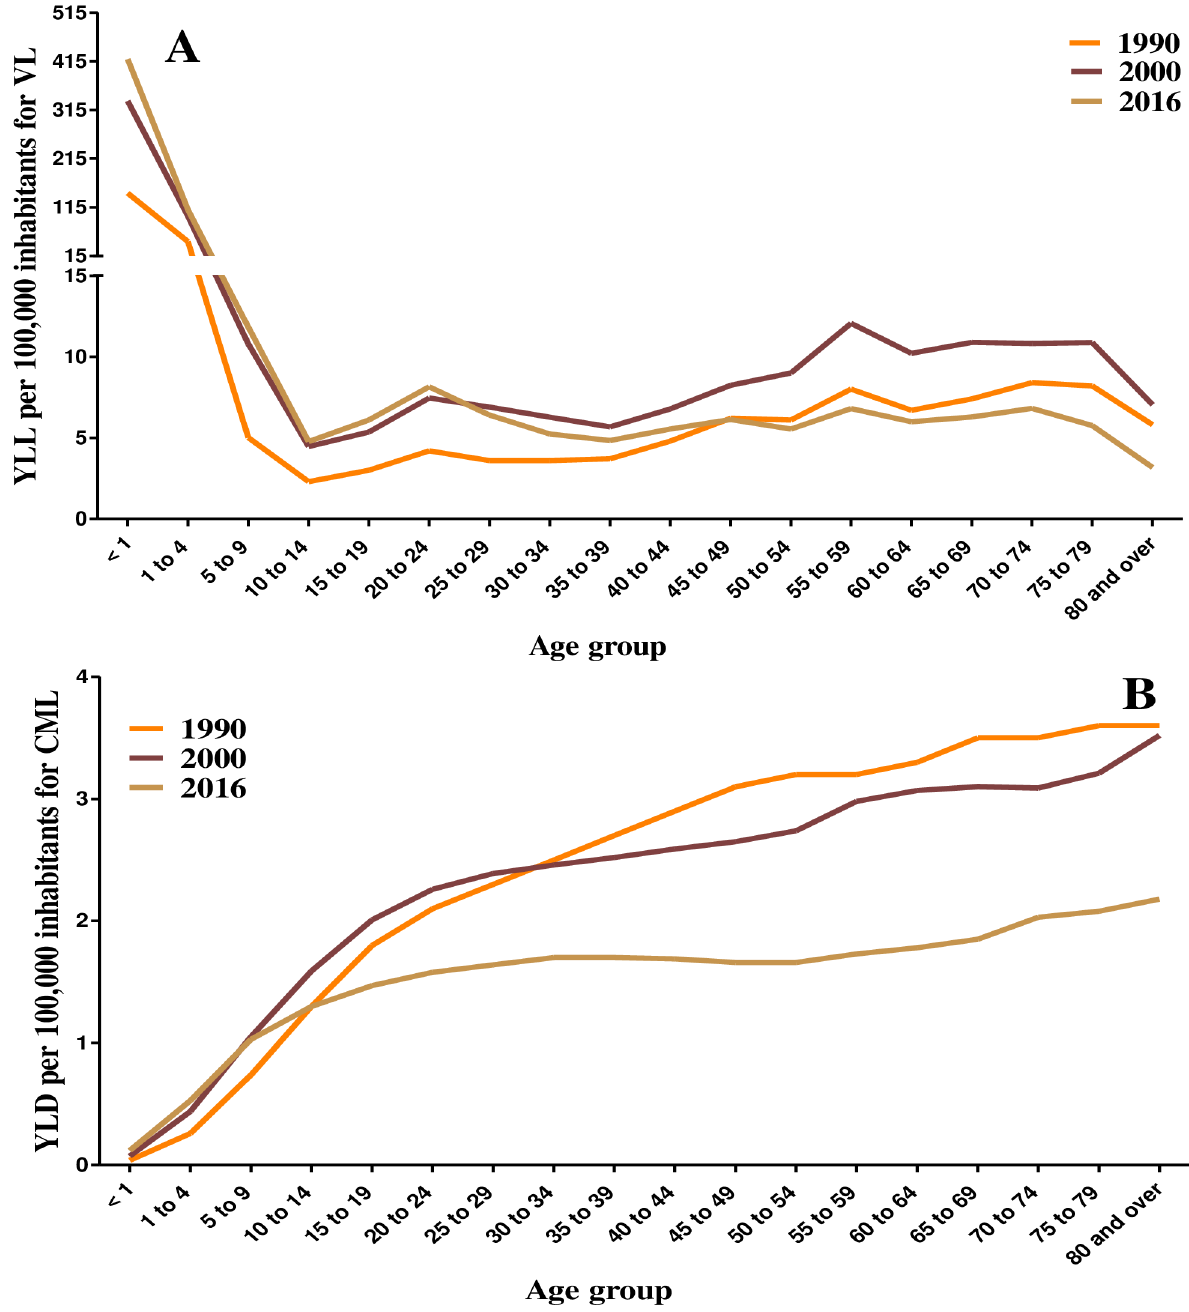
Fig 3. Age-standardized rates of years of life lost (YLL) for Visceral Leishmaniasis (VL) (A) and years lived with disability (YLD) for Cutaneous and Mucocutaneous Leishmaniasis (CML) (B) per 100,000 inhabitants by age group, Brazil in 1990, 2000 and 2016. CML mortality was assumed to be zero; YLD is low for VL (premature mortality predominates in VL). GBD Study